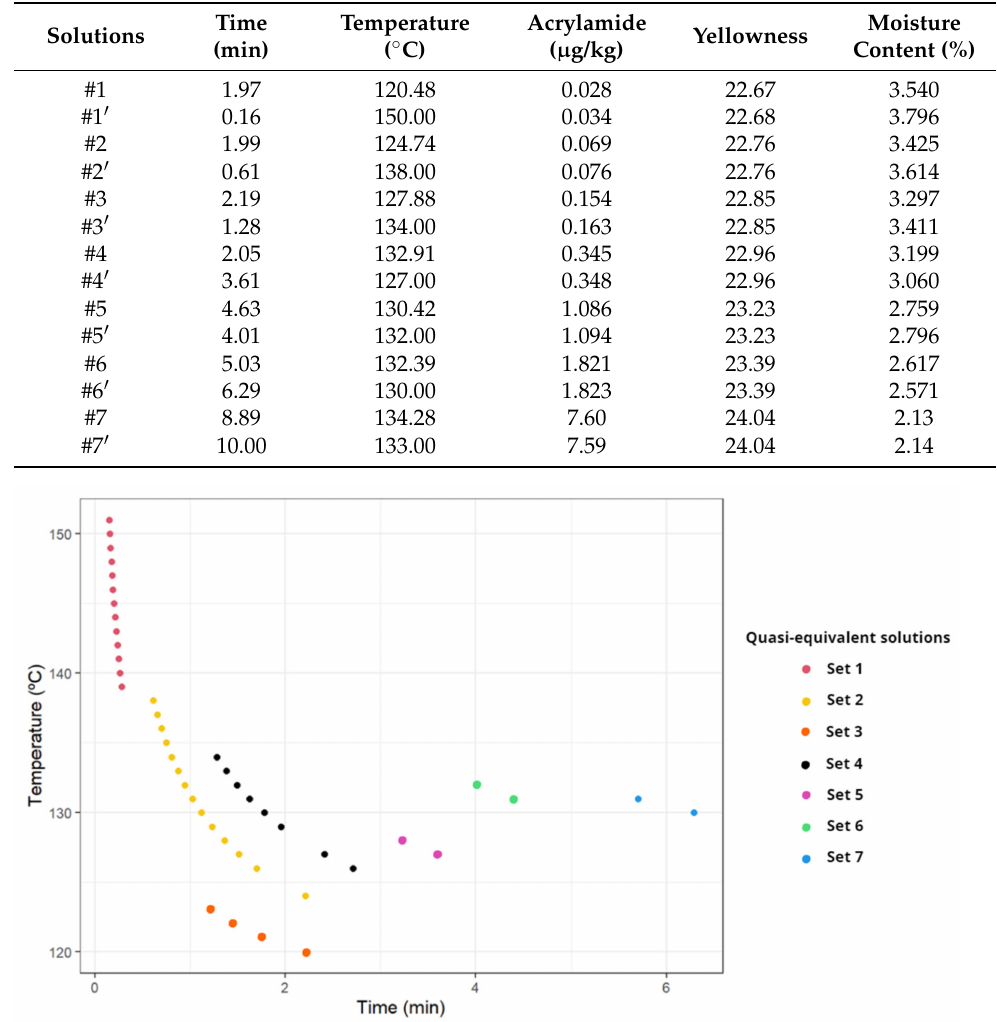
Figure 4. Selected sets of quasi-equivalent